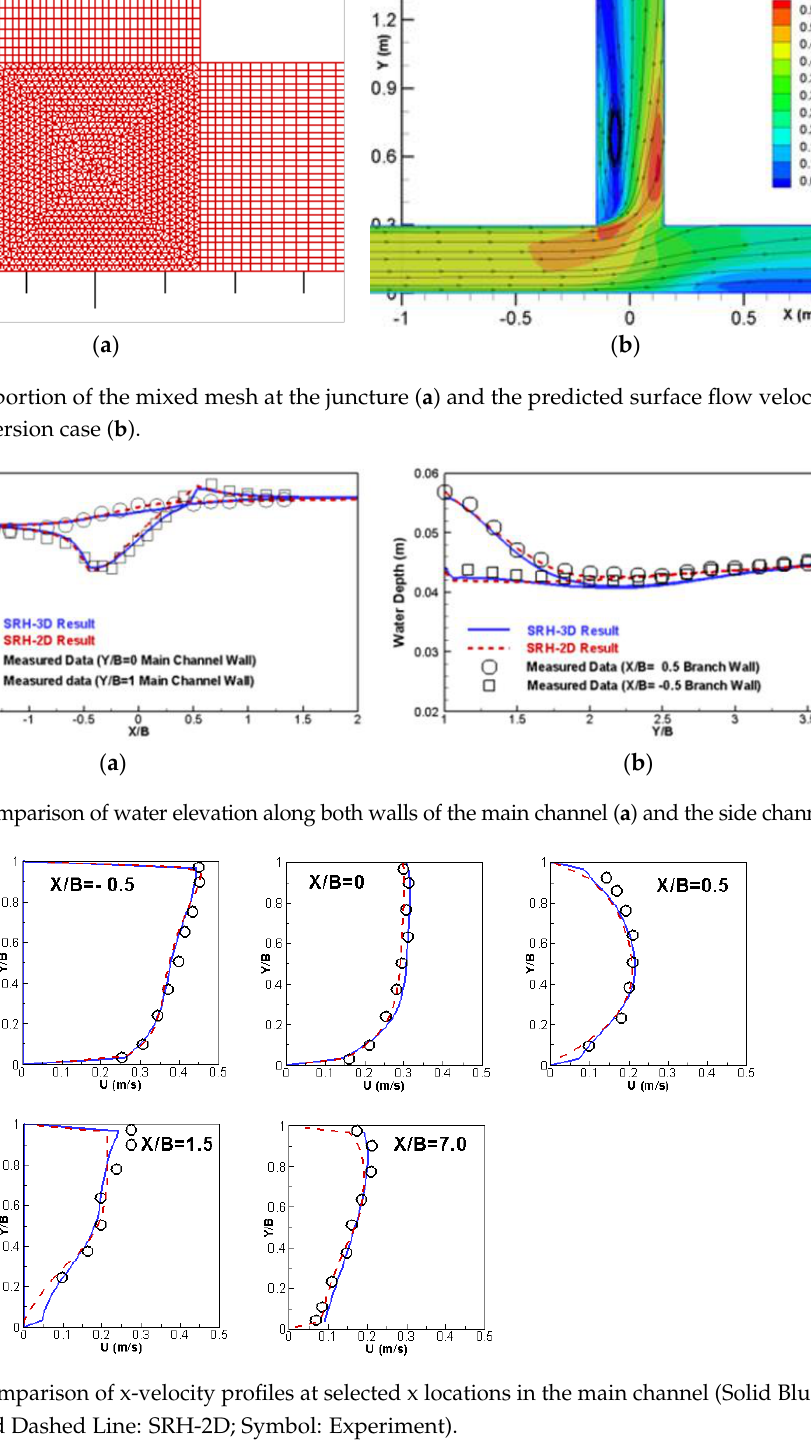
Figure 4. Comparison of V velocity profiles at selected y locations in the side channel (Solid Blue Line: SRH-3D; Red Dashed Line: SRH-2D; Symbol: Experiment). 5.2. Flow in a Sharply Curved Bend An open channel flow with a sharp 180° rectangular bend was experimentally studied in [45]. A bend with a mean radius-to-width ratio of 3.0 and less is considered strongly curved and exhibits highly 3D flow characteristics [46]. The Rozovskii bend has a mean radius-to-width ratio of 1.0, so it belongs to the very sharp bend category. The same case was subject to a number of numerical studies, such as a 2D depth-averaged modeling in [46], a 2D modeling explicitly taking into account the secondary flow in [47], and a 3D NS solver modeling in [48]. The model domain and bed geometry are shown in Figure 5a. The approach and exit channels are straight, 1.6 m in length, and 0.8 m in width. The bend has a radius of 0.4 m for the inner wall. The numerical modeling parameters are as follows. The entire channel has a flat smooth bottom. The discharge at the entrance is 0.0123 m 3 /s, resulting in an average velocity of 0.265 m/s, Reynolds number of 15,600, and Froude number of 0.11. The water elevation at the model exit is extrapolated from the experimental data. The horizontal mesh adopts the mixed triangles (two zones) and quadrilaterals (Figure 5a). A total of 20 vertical mesh cells are chosen, leading to a total of 165,280 3D mesh cells. Predicted water depth along the inner and outer sidewall is compared with the experimental data in Figure 5b. It is seen that the water surface elevation is higher at the outer bank than at the inner bank — the expected super-elevation effect. The model results match well along the outer wall and the elevation is under-predicted along the inner wall. The SRH-3D model indeed has a better